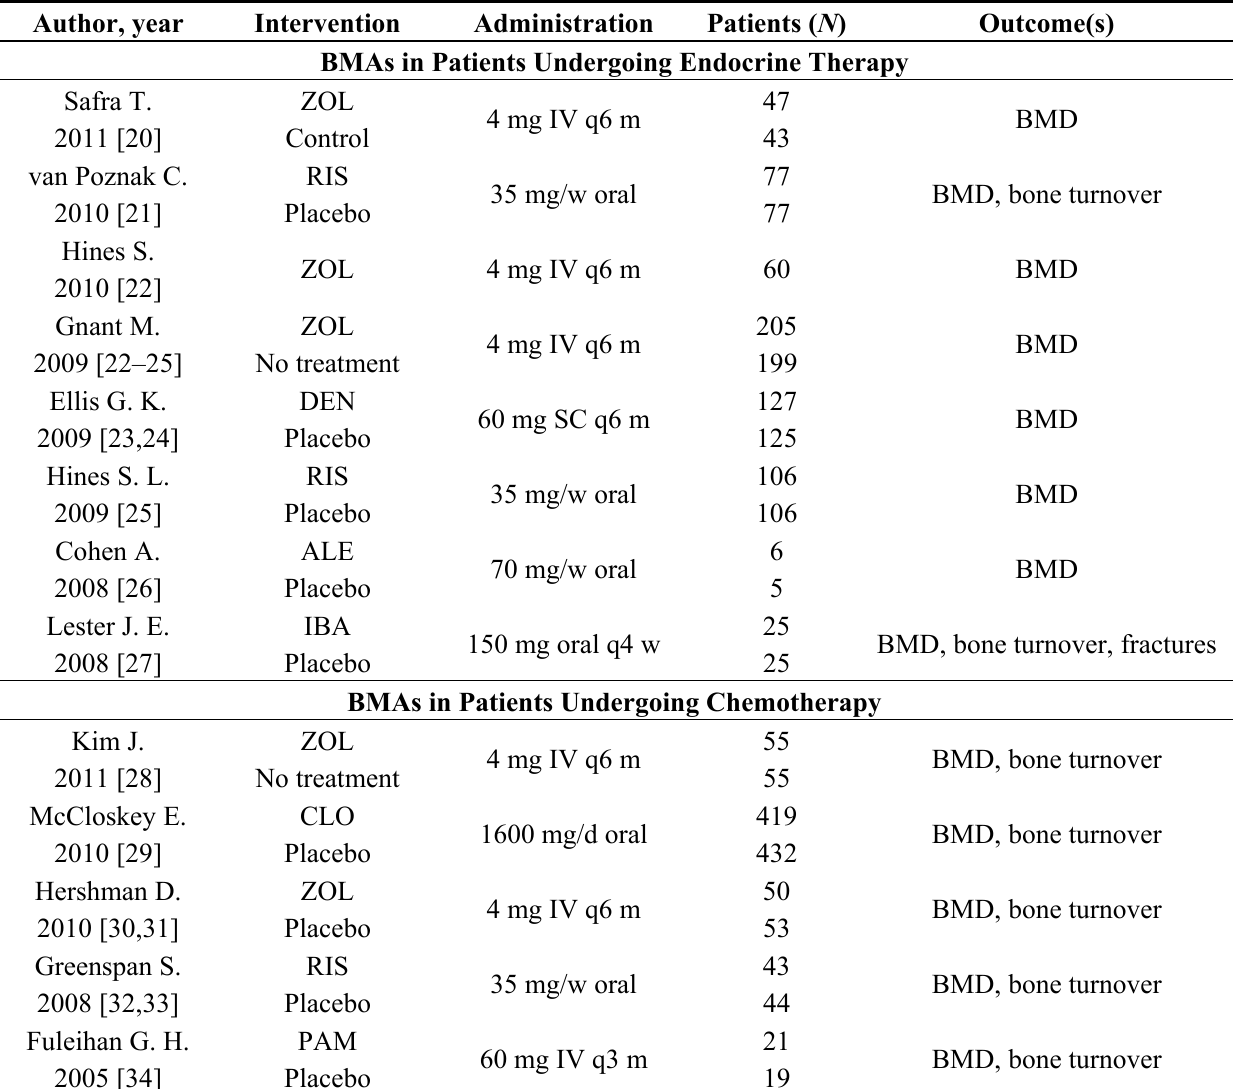
Table 1. Evidence on the use of bone modifying agents (BMAs) in patients with treatment-related bone loss from breast